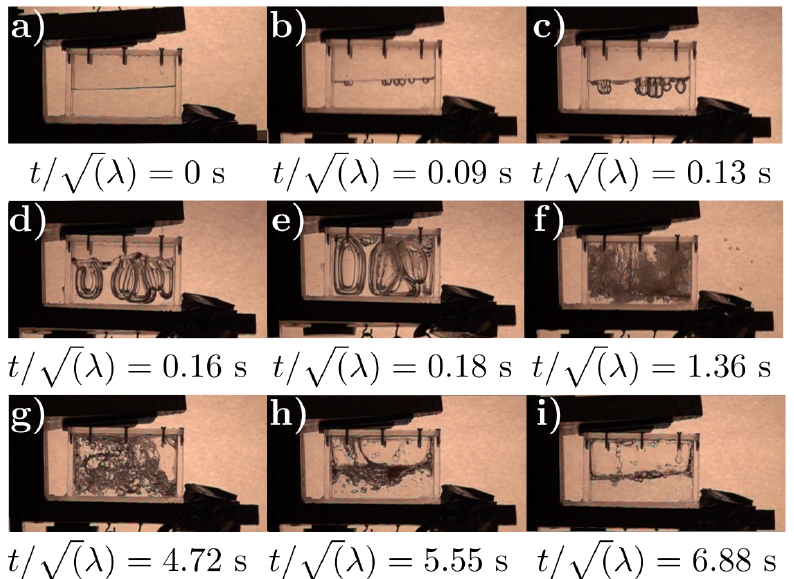
Figure 2. Experimental snapshots of the reference case for λ = 1/5. ( a ) Initial state. ( b ) Ripple forma- tion in the free surface. ( c ) Rayleigh–Taylor instabilities formation. ( d ) Rayleigh–Taylor instabilities growth. ( e ) First liquid-to-wall impact. ( f ) Violent and turbulent regime. ( g ) Ending of the turbulent and violent regime when F slosh is lower than the liquid weight. ( h ) Last lateral impacts and standing wave regime. ( i ) Restoration of the initial state with rotary